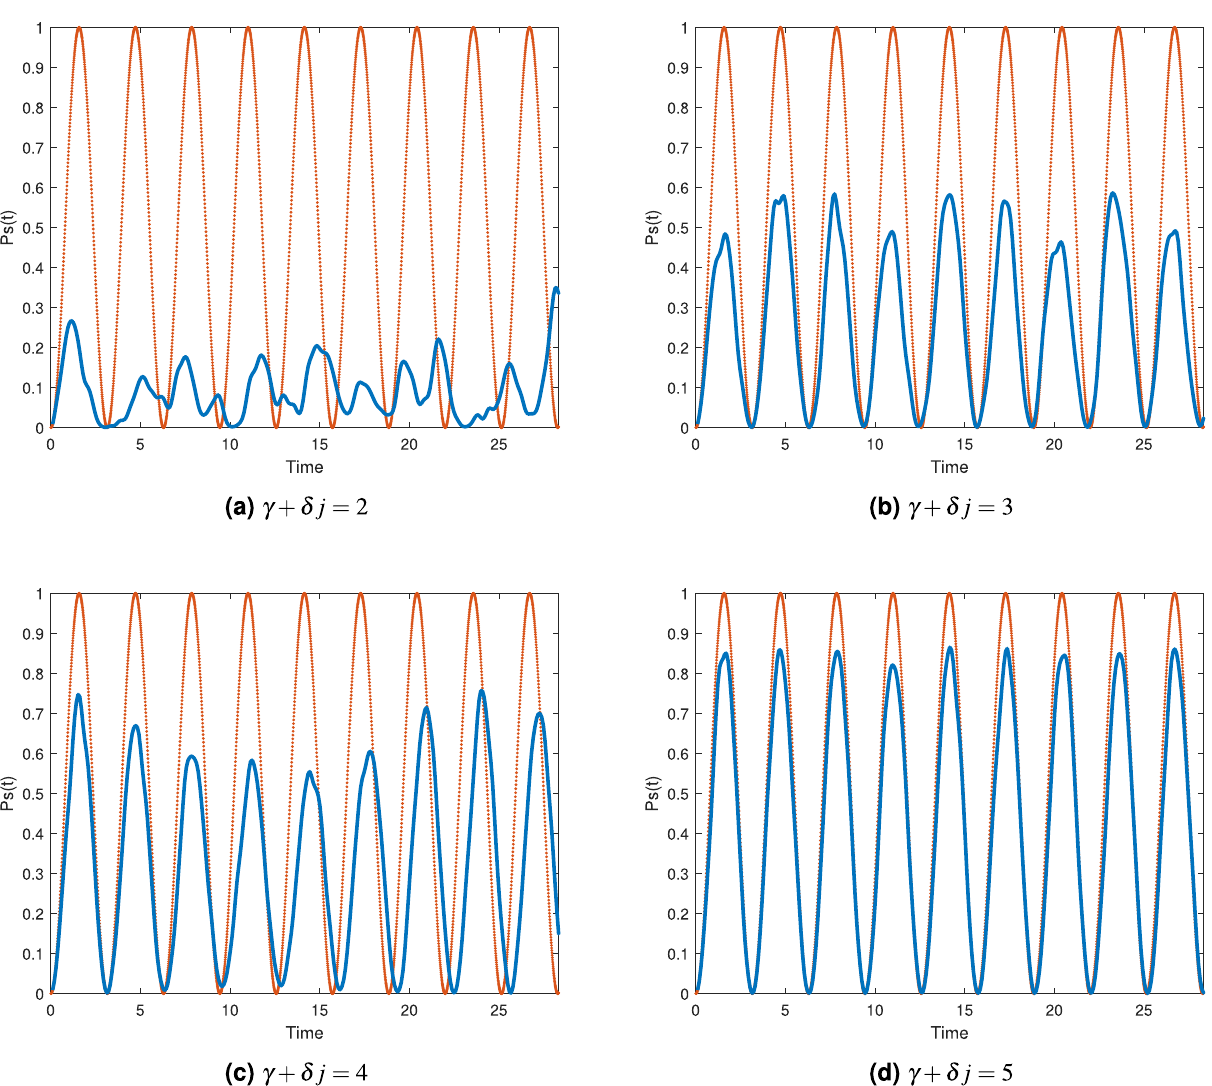
Hamming distance of